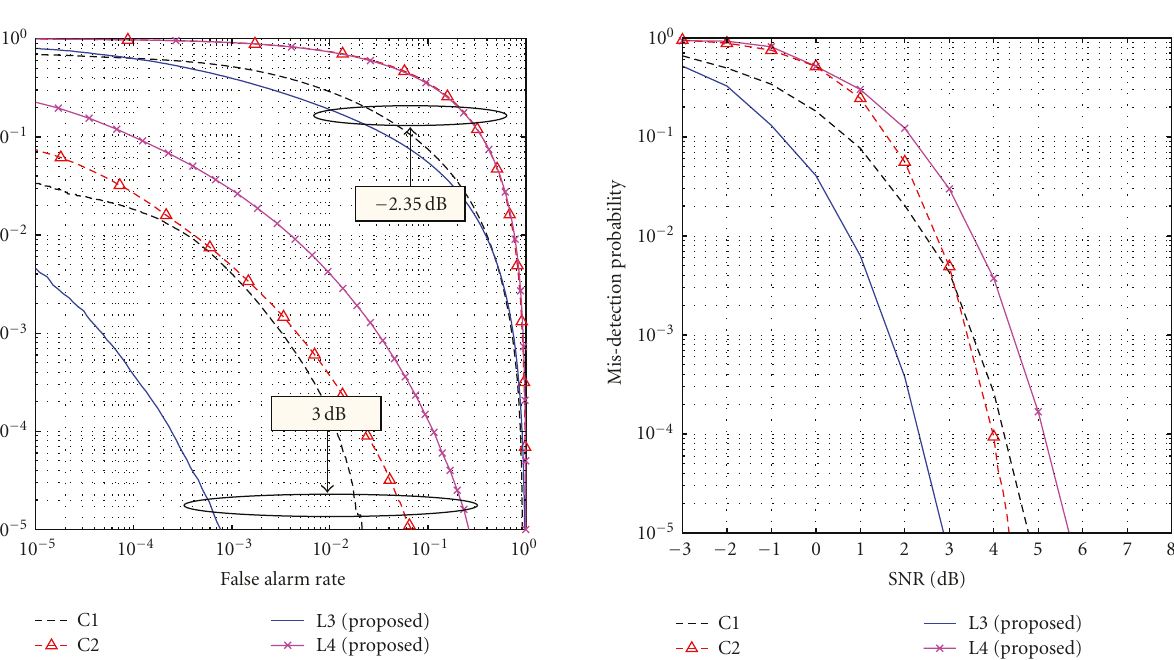
Figure 8: Misdetection probability at di ff erent SNR values (FAR = 10 − 3 , f m T s = 0 . 2).